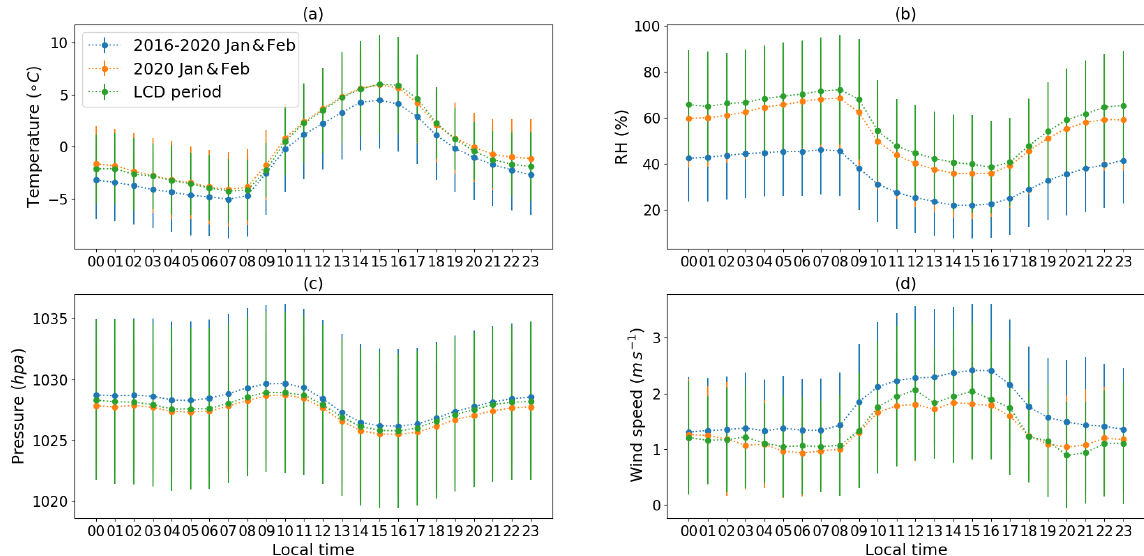
Figure 1. The mean diurnal pattern of meteorological parameters, including temperature (a) , RH (b) , sea level pressure (c) , and wind speed (d) during the LCD period (24 January–16 February 2020), January and February 2020, and January and February 2016–2020. The solid circles and bars represent the mean value and the standard deviation, respectively.